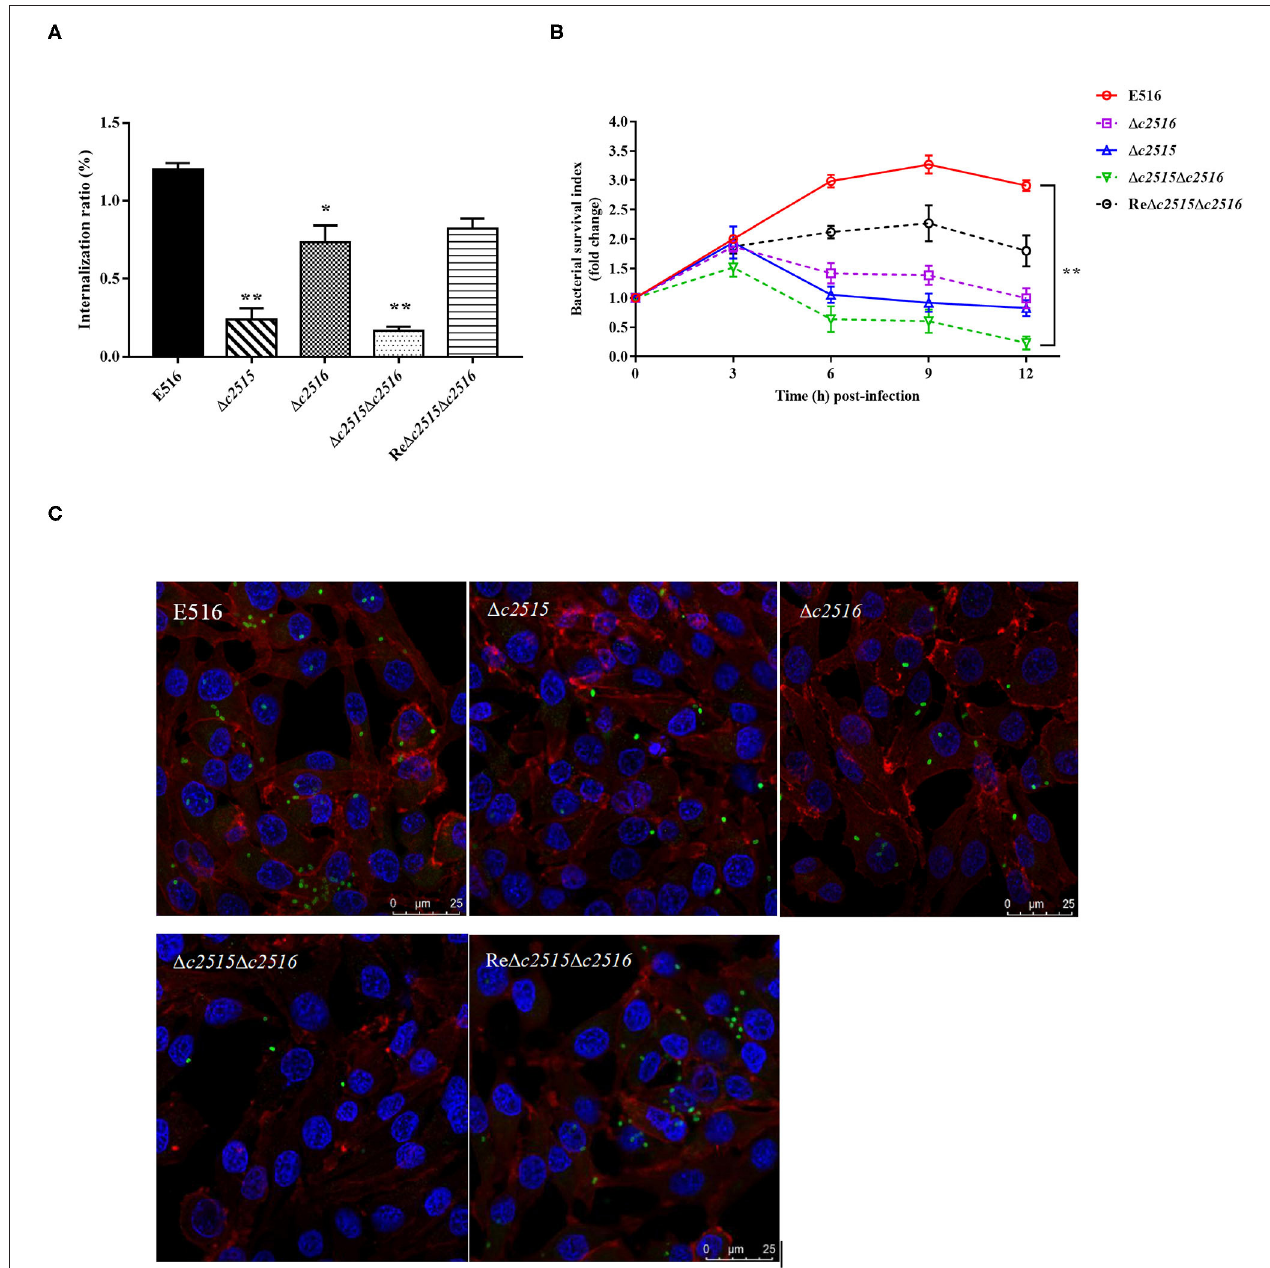
FIGURE 5 | Intracellular survival of bacteria in HD-11 chicken macrophages. (A) Bacterial internalization into HD-11 cells. (B) The intracellular survival of the WT strain E516, the isogenic 1 c2515 , 1 c2516 , and 1 c2515 1 c2516 mutants, and the complemented strain Re 1 c2515 1 c2516 , respectively, were compared over a 12h period. The standard errors of the means of three independent experiments are shown. Asterisks indicate statistically signifificant differences (** P < 0.01, * P < 0.05). (C) Laser-scanning confocal microscopy visualization of the surviving bacteria in the HD-11 macrophage cells at 12h post-infection. Bacteria were incubated with polyclonal chicken anti-APEC O1 serum and stained with FITC goat anti-chicken IgG, after which the infected cells were treated with DAPI (nuclei staining) and phalloidin-Alexa Fluor 568 (actin